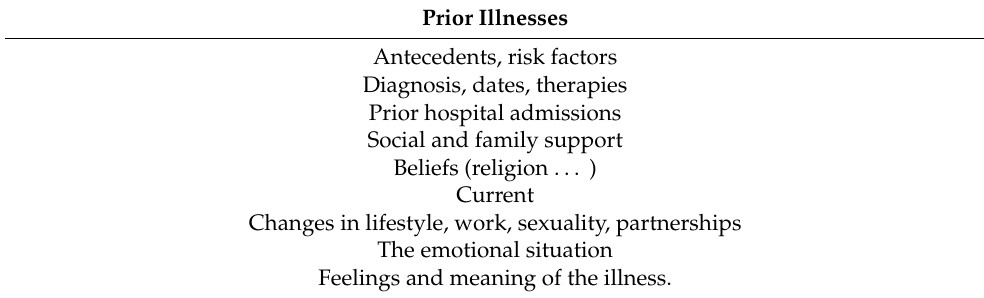
Table 1. Interview